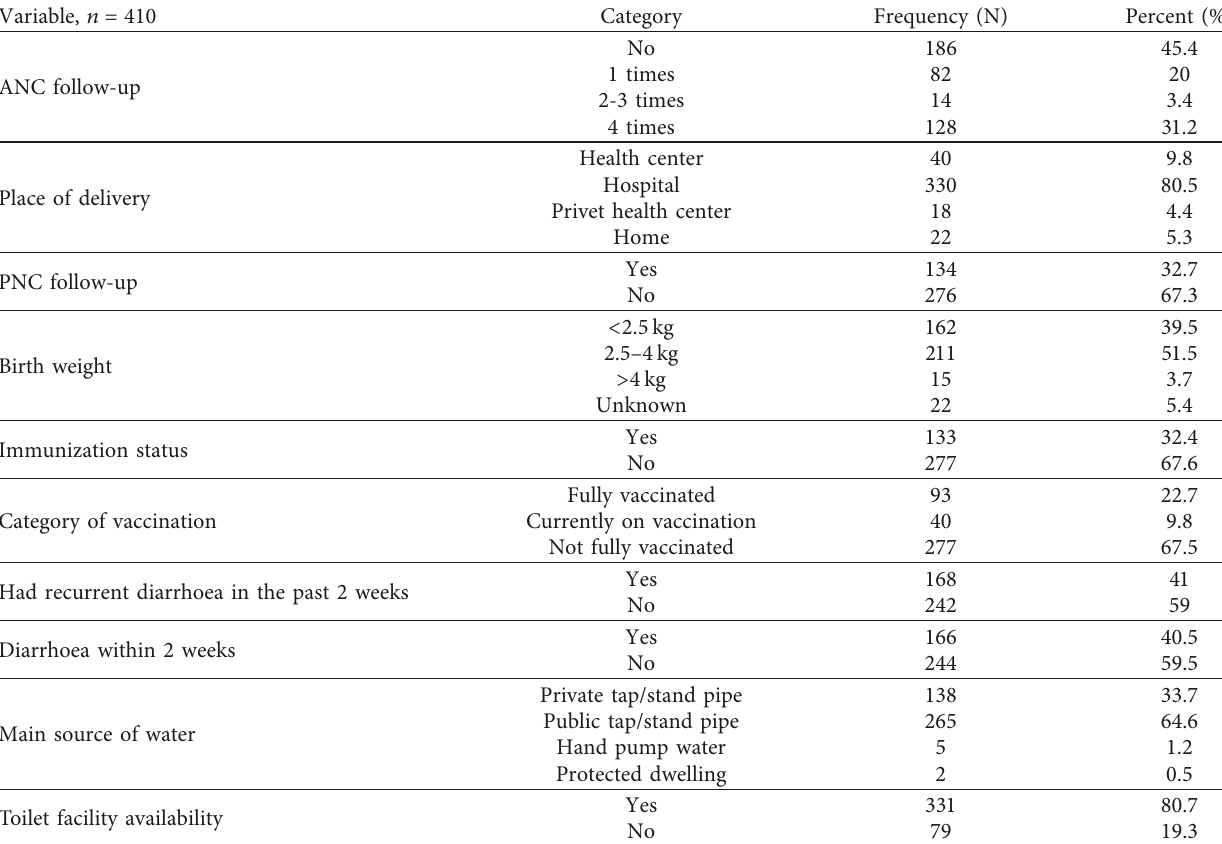
Table 2: Environmental and health-care characteristics of children aged 5 to 59 months in Merhabete woreda, Ethiopia, 2017 ( n � 410).